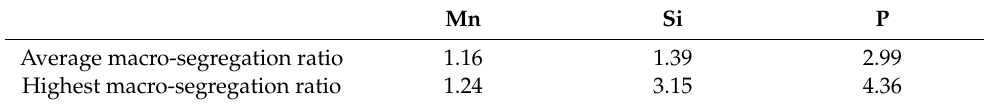
Table 2. Average and peak macro-segregation ratios in regions E (equiaxed) and A (axial).